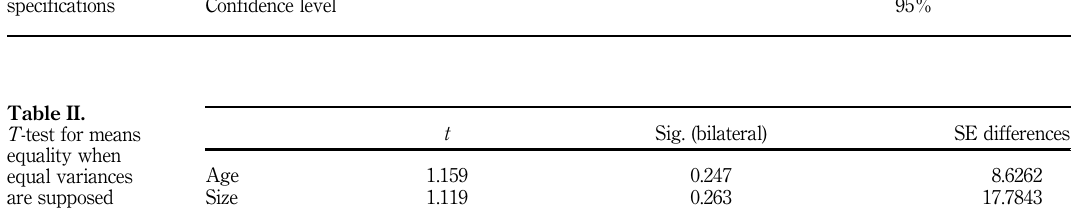
Table I. Research specifications